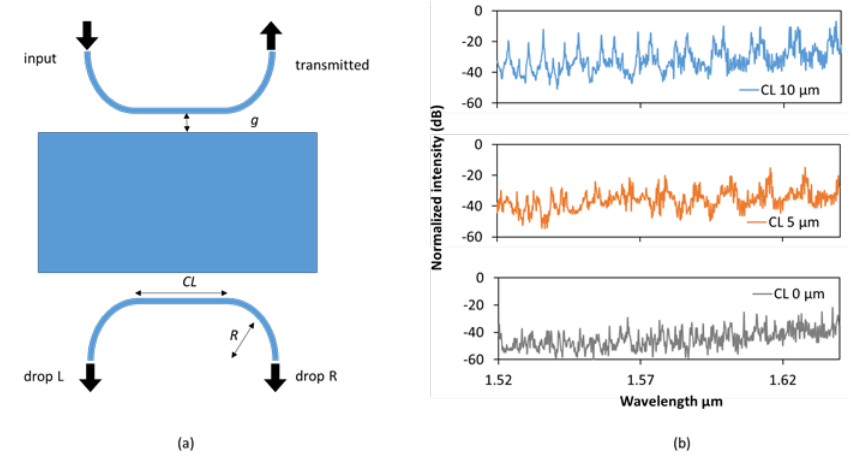
Figure 5. ( a ) Schematic of the device; ( b ) experimental Drop R spectrum for different coupling lengths.